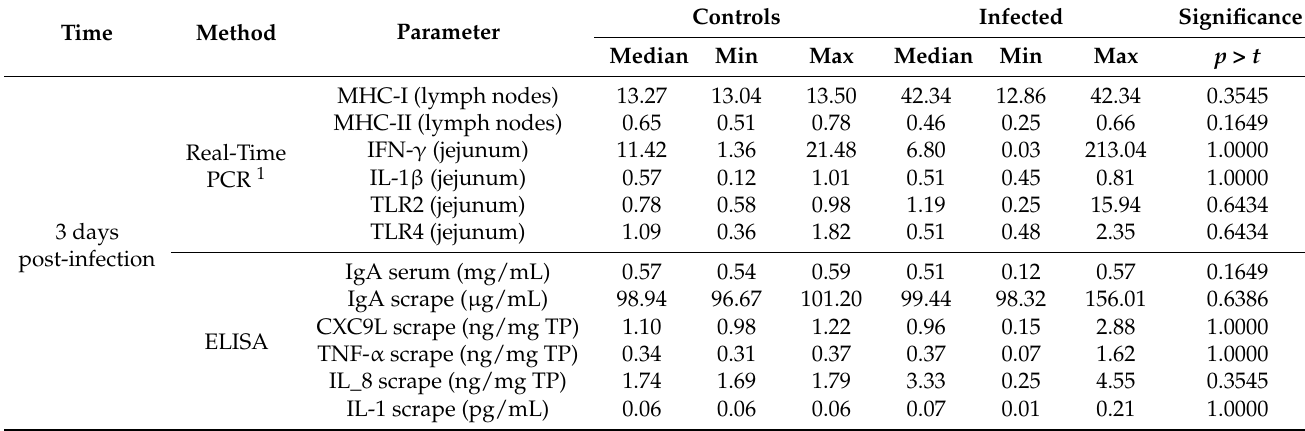
Table 7. Median parameters obtained in infected and controls at 3 and 9